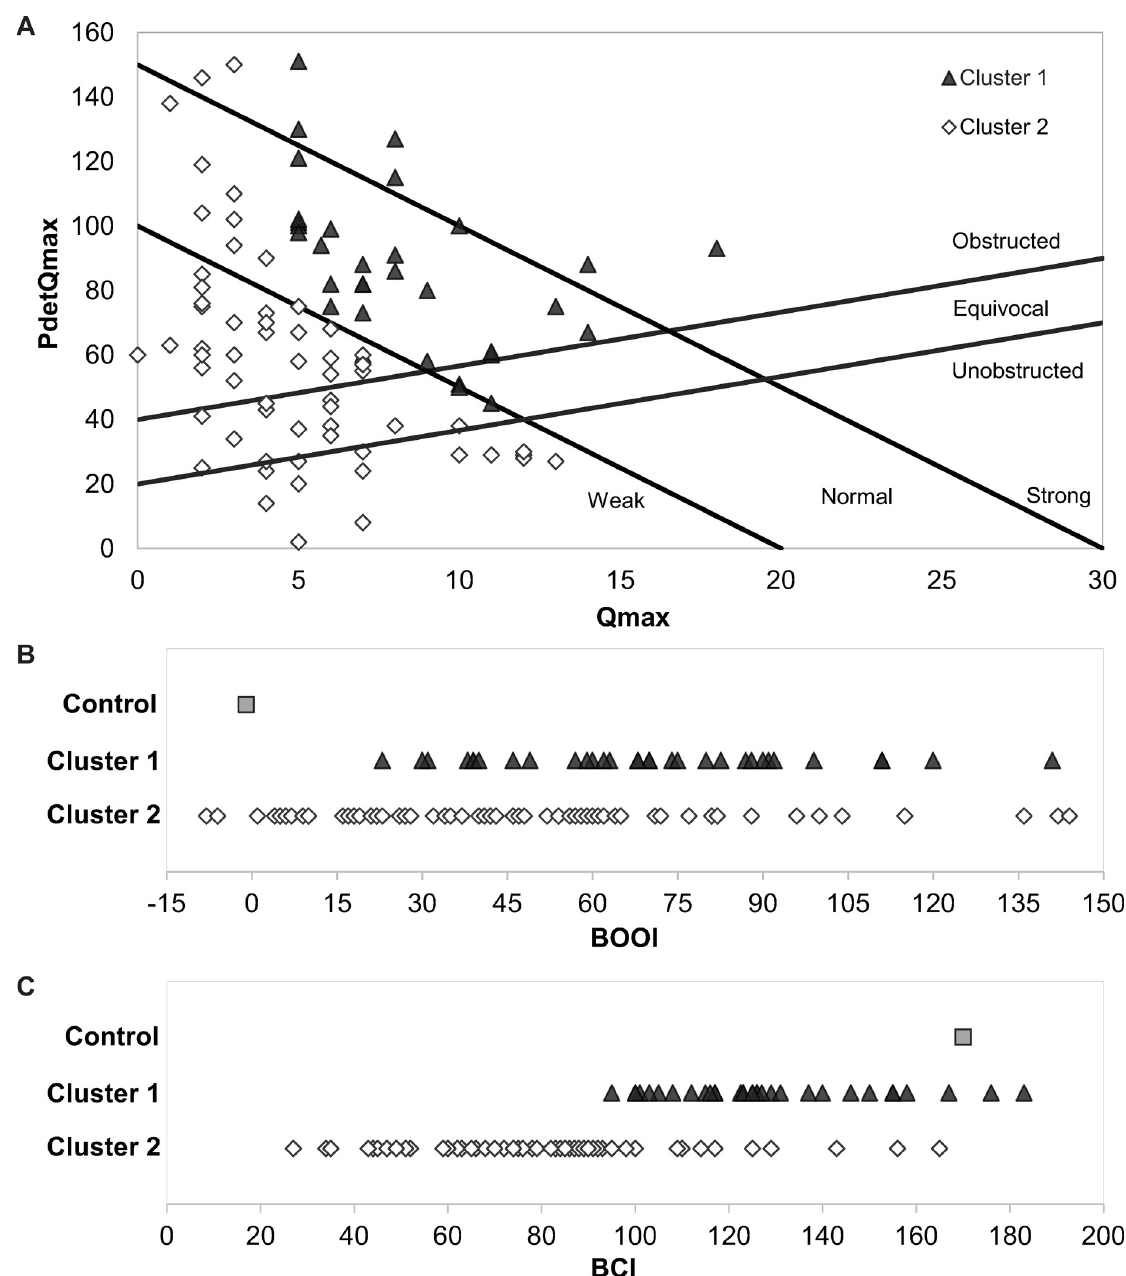
Fig 3. Preoperative urodynamic data sorted by cluster. Cluster 1: filled triangles. Cluster 2: open diamonds. Filled Square are mean values calculated from published urodynamic data on young healthy controls [1]. (A) ICS nomogram. (B) BOOI: Unobstructed < 20, Equivocal 20–40, Obstructed > 40. (C) BCI: Weak < 100, Normal 100–150, Strong >